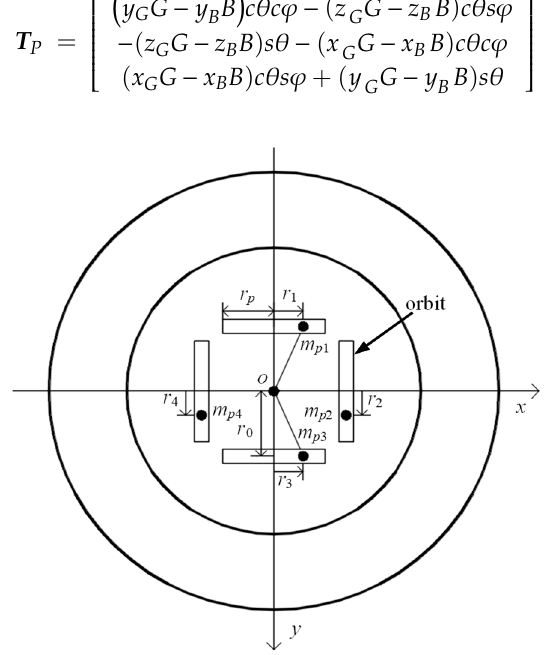
Figure 3. The attitude adjustment system of the DTUG.